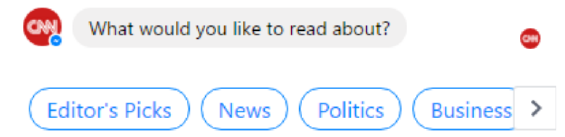
Fig. 4. TechCrunch’s simple message example.